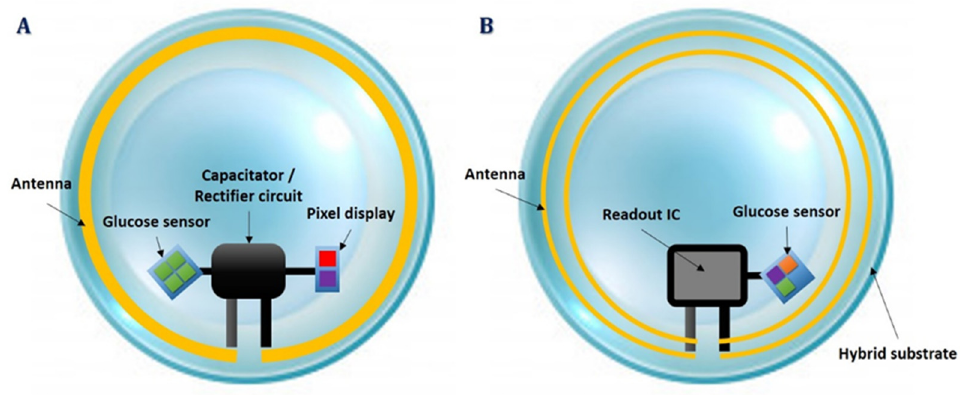
Figure 2. Smart contact lens integration systems; passive contact lens sensor circuit ( A ) and active contact lens sensor hardware ( B ).